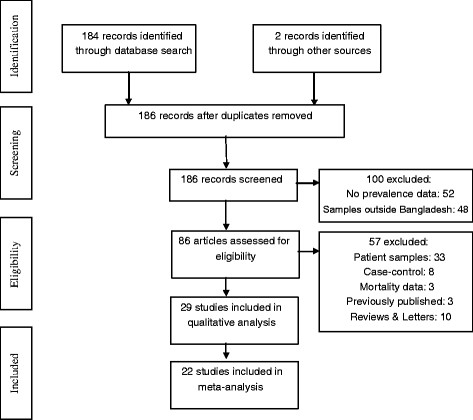
Consort diagram.